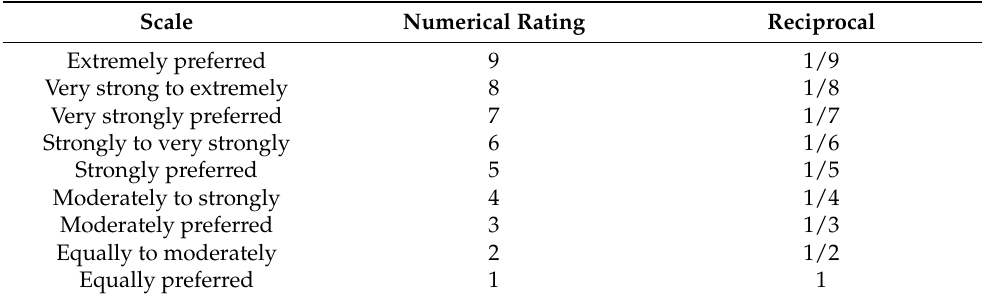
Table 1. The AHP